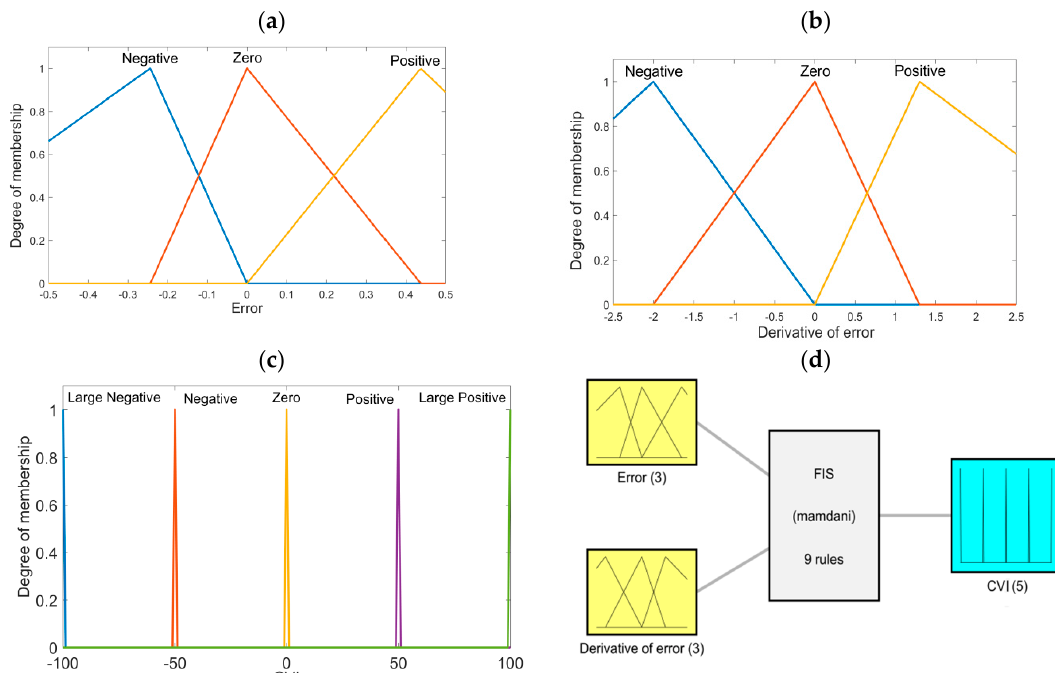
Figure 10. ( a ) Membership functions representing fuzzy values of the control error. ( b ) Membership functions representing fuzzy values of the derivative of the control error. ( c ) Membership functions representing the fuzzy control value output. ( d ) Block diagram of the fuzzy reasoning applied for fuzzy PD controller.